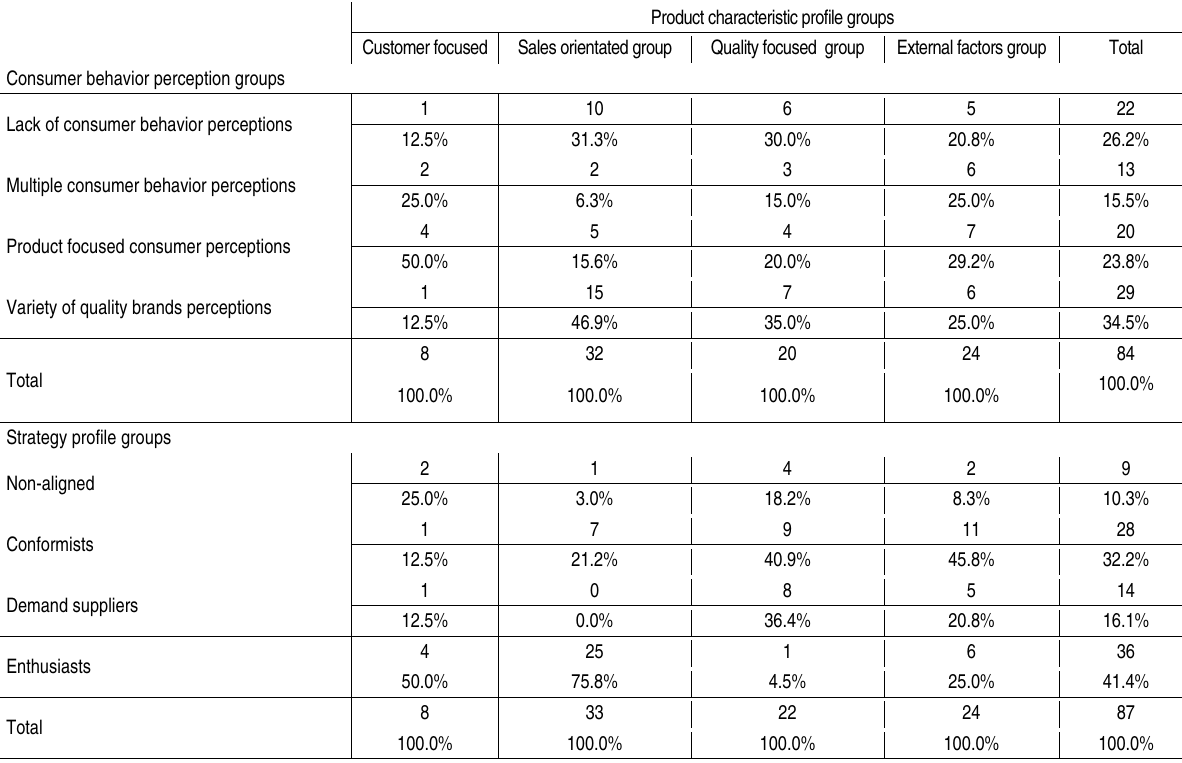
Table 4. Strategy tendencies and perceptions of consumer behavior of the different product characteristics groups